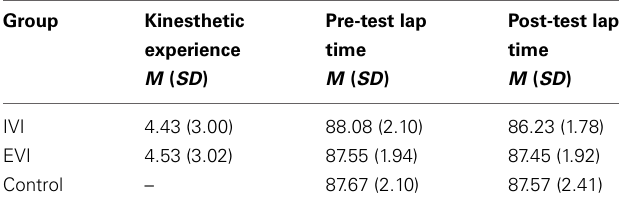
Table 1 | Kinesthetic experience and lap-time (seconds) at pre-test and post-test in Experiment 1.